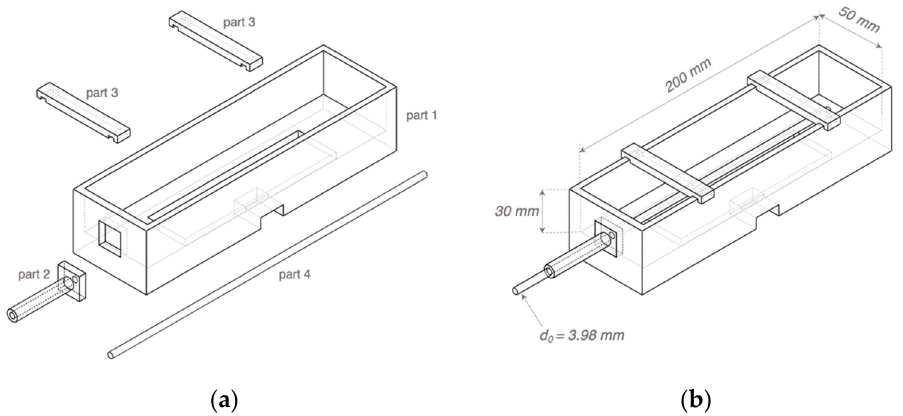
Figure 7. Three ‐ dimensional (3D) schematics of the phantom mould: ( a ) separated 3D printed parts 1–3 and the metal rod part 4; ( b ) the assembled